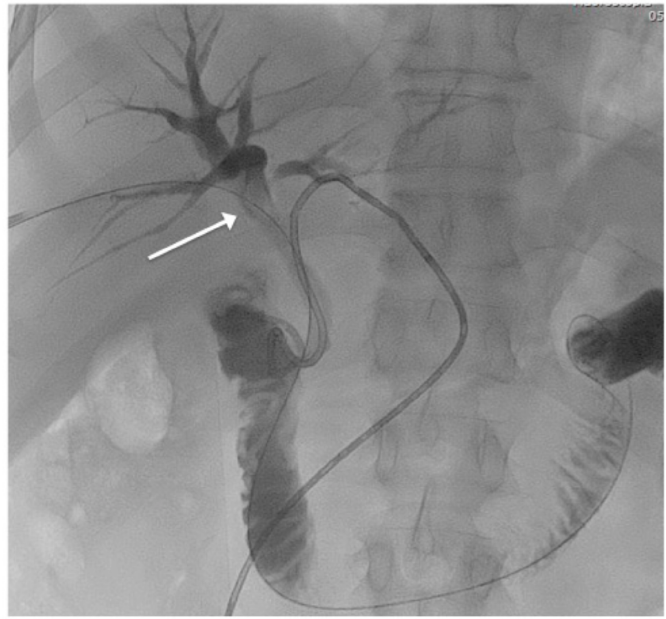
Figure 1. Percutaneous cholangiography confirmed the presence of a biliary stone (white arrow) in the right hepatic